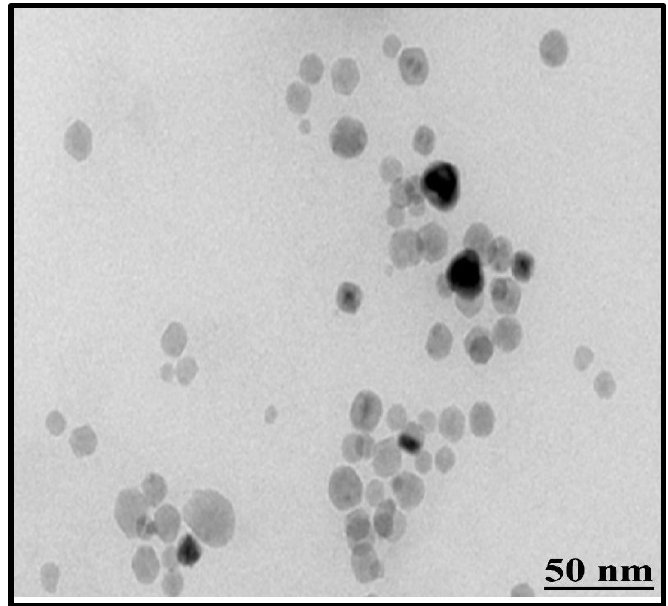
Figure 8. TEM micrographic image of mycosynthesized ZnO NPs.